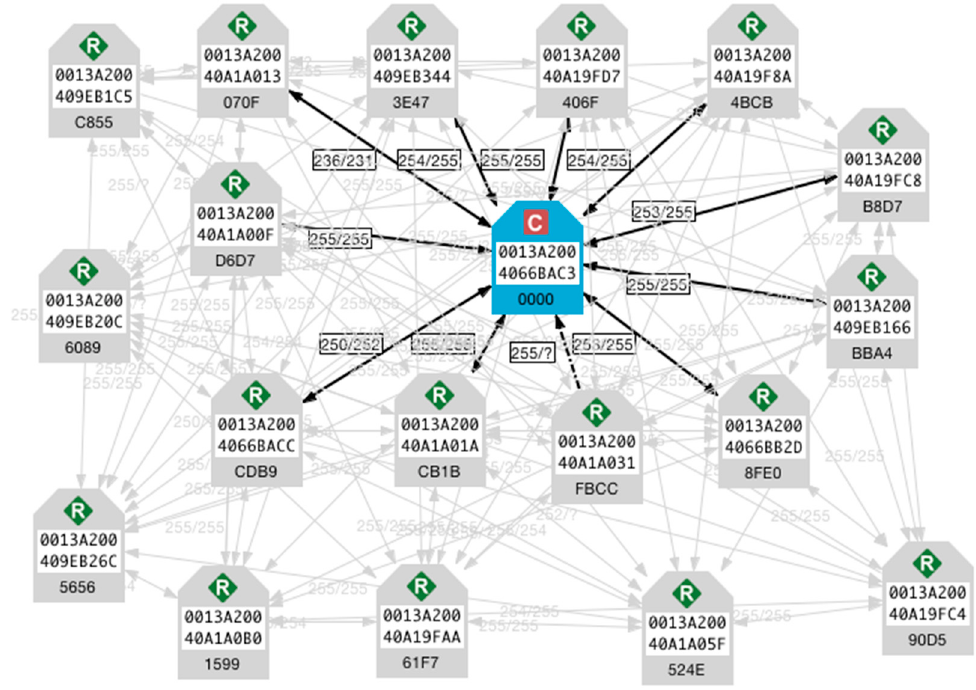
Figure 4. Schematic view of the ZigBee mesh network with 18 endpoints.